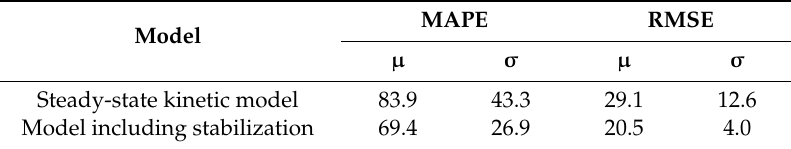
Table 2. Statistical results of the accuracy indicator